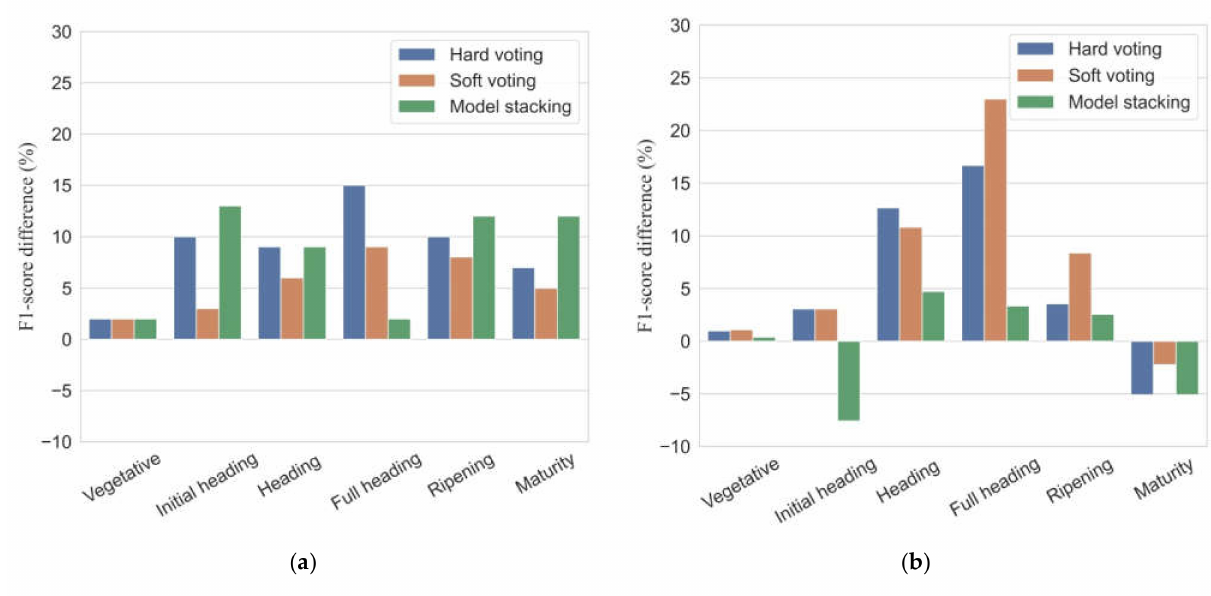
Figure 8. Differences in F1-scores (%) between ensemble models and the single best classifier (GNB) in calibration ( a ) and validation ( b )